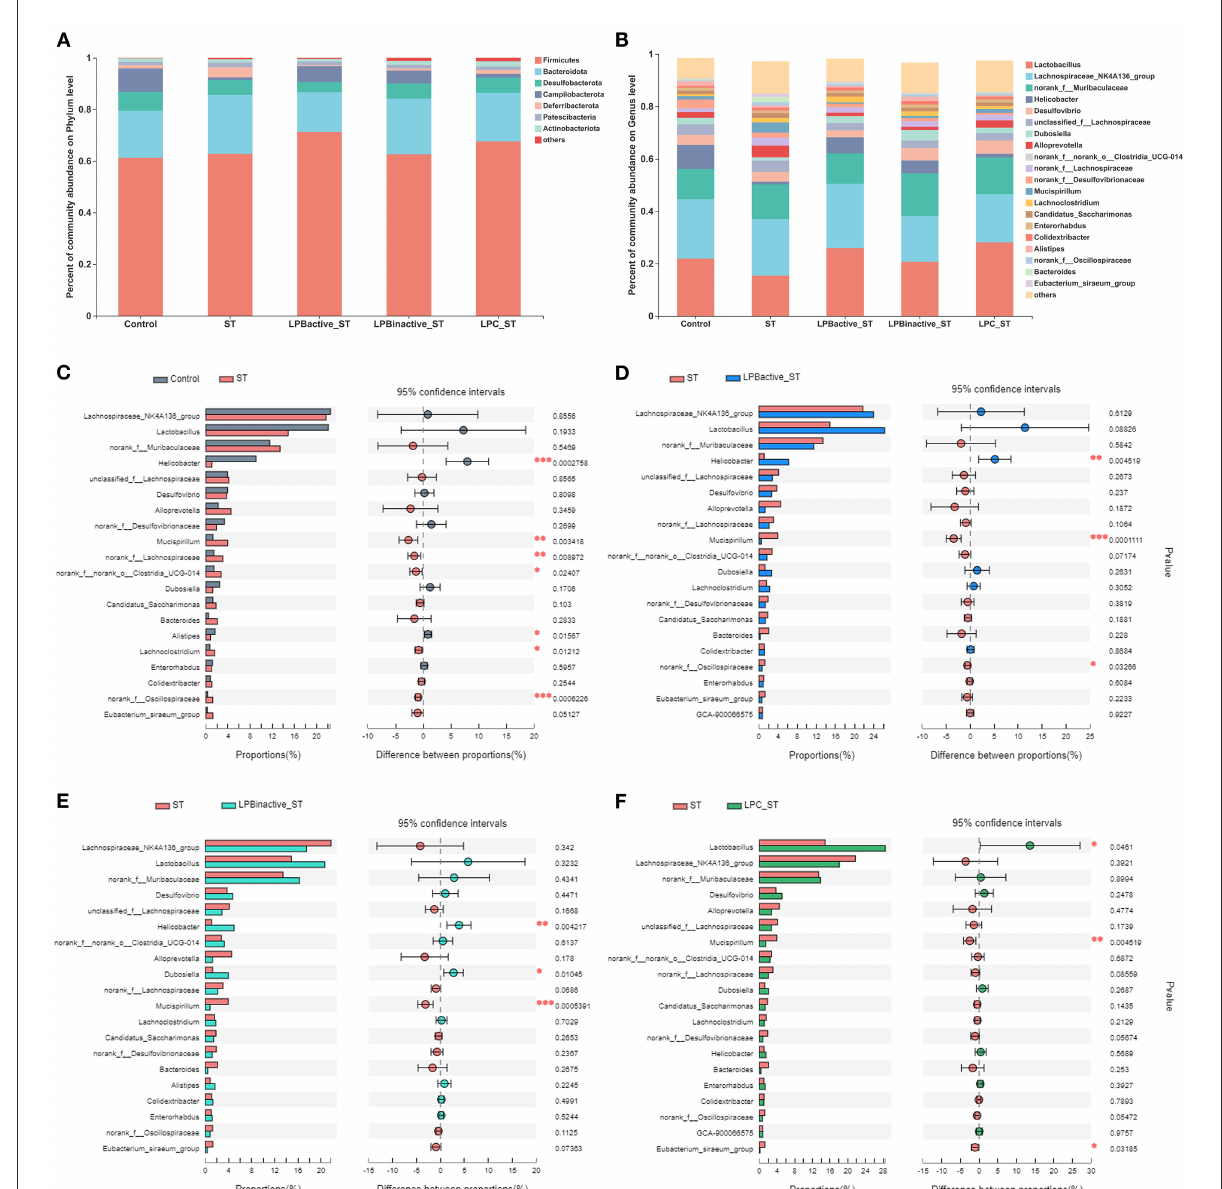
FIGURE11 The LP postbiotics optimized the composition of cecal microbiota. (A) Bar graph of microbiota composition at the phylum level. (B) Bar graph of microbiota composition at the genus level. (C–F) Comparisons of gut microbiota (Control vs. ST, ST vs. LPB active + ST, ST vs. LPB inactive + ST, ST vs. LPC + ST) at genus level by statistical analysis of taxonomic and functional profiles (STAMP) ( N = 12 in each group). The data were analyzed by Student’s t -test ( N = 12 in each group). * p < 0.05, ** p < 0.01, *** p <